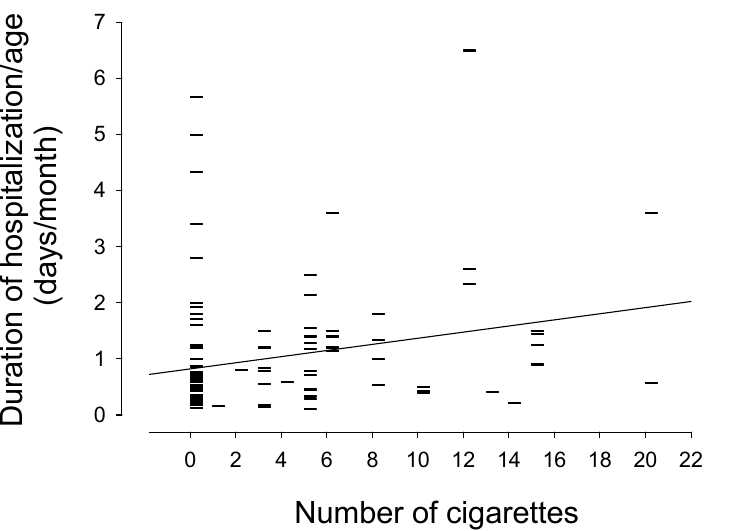
Figure 1. Linear correlation between duration of hospitalization/age and reported number of cigarettes smoked during pregnancy. Upon multivariable analysis, after adjusting for confounding factors related to other risk factors for wheezing (such as the passive exposition for the pregnant women or in the post-natal period, gender, intrauterine growth restriction, familial atopy), smoking one cig- arette per day during pregnancy was statistically associated with an increase in hospital stay of 0.06 days/month of life over the first 2 years of life ( p = 0.03), as depicted in Table 4. The standardized β of this association was 0.27 after standardization of the coefficients, i.e., an in- crease by one standard deviation of the independent variable (number of cigarettes smoked per day during pregnancy) induced an increase of 0.27 SD of the hospital stay (in days/month). Table 4. Duration of hospitalization/age in multivariable analysis.